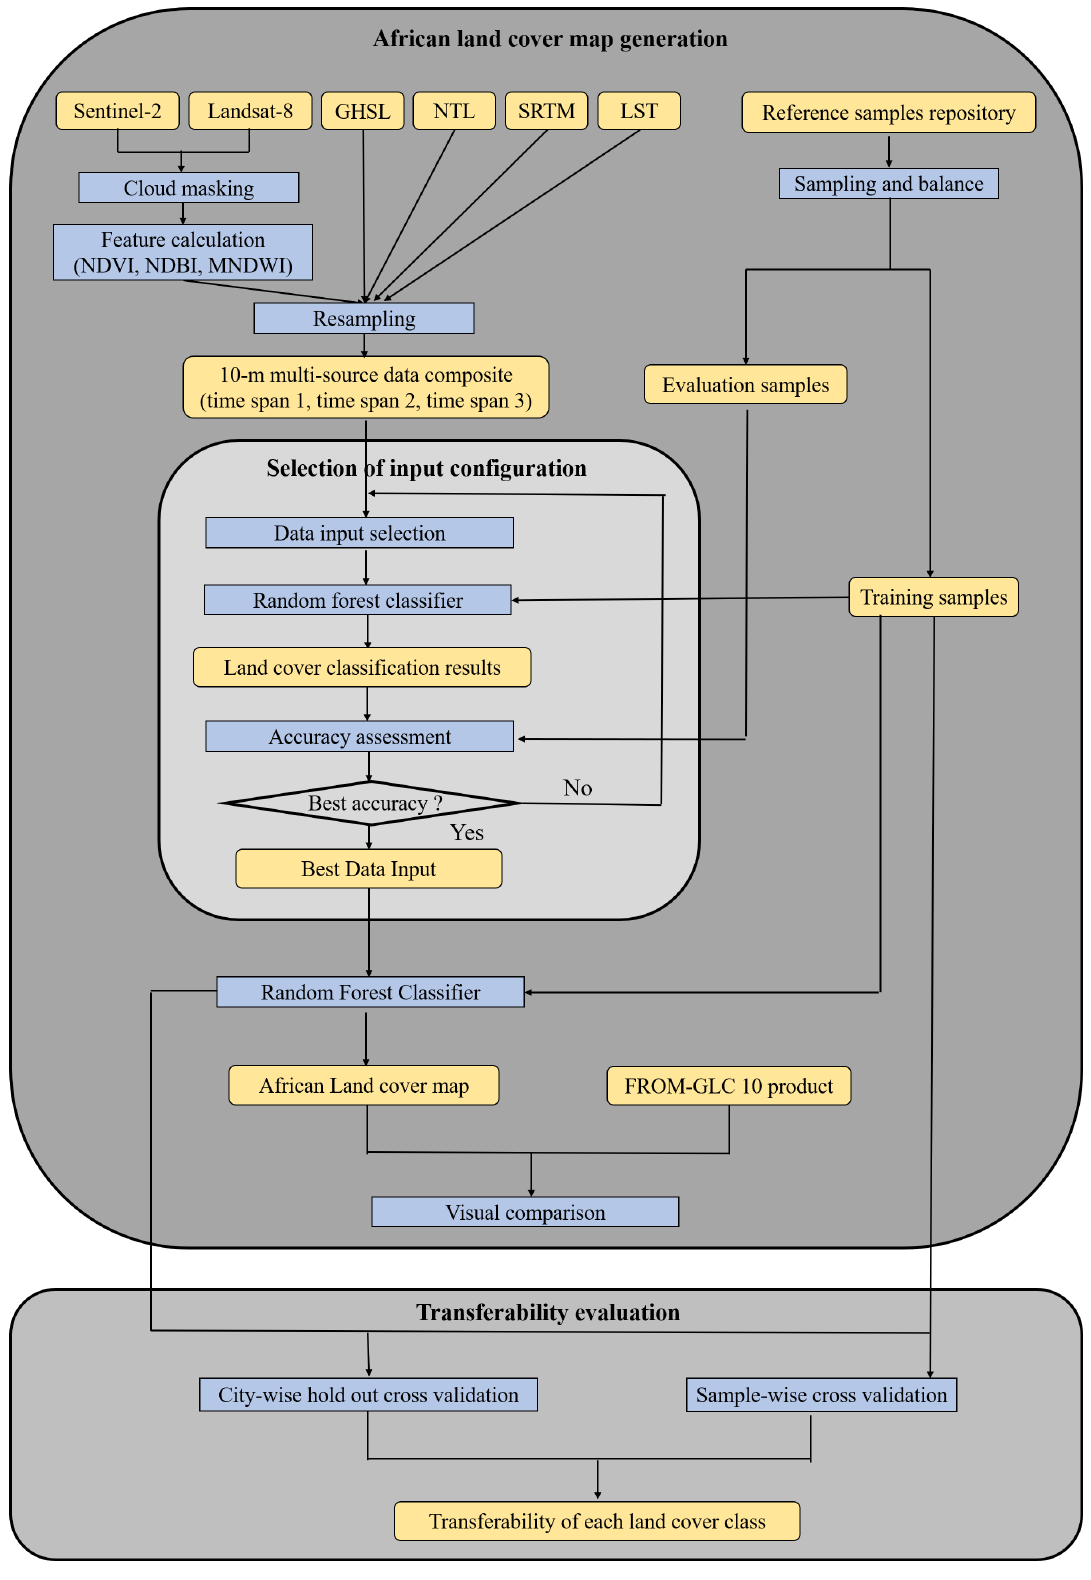
Figure 1. Flowchart of the proposed